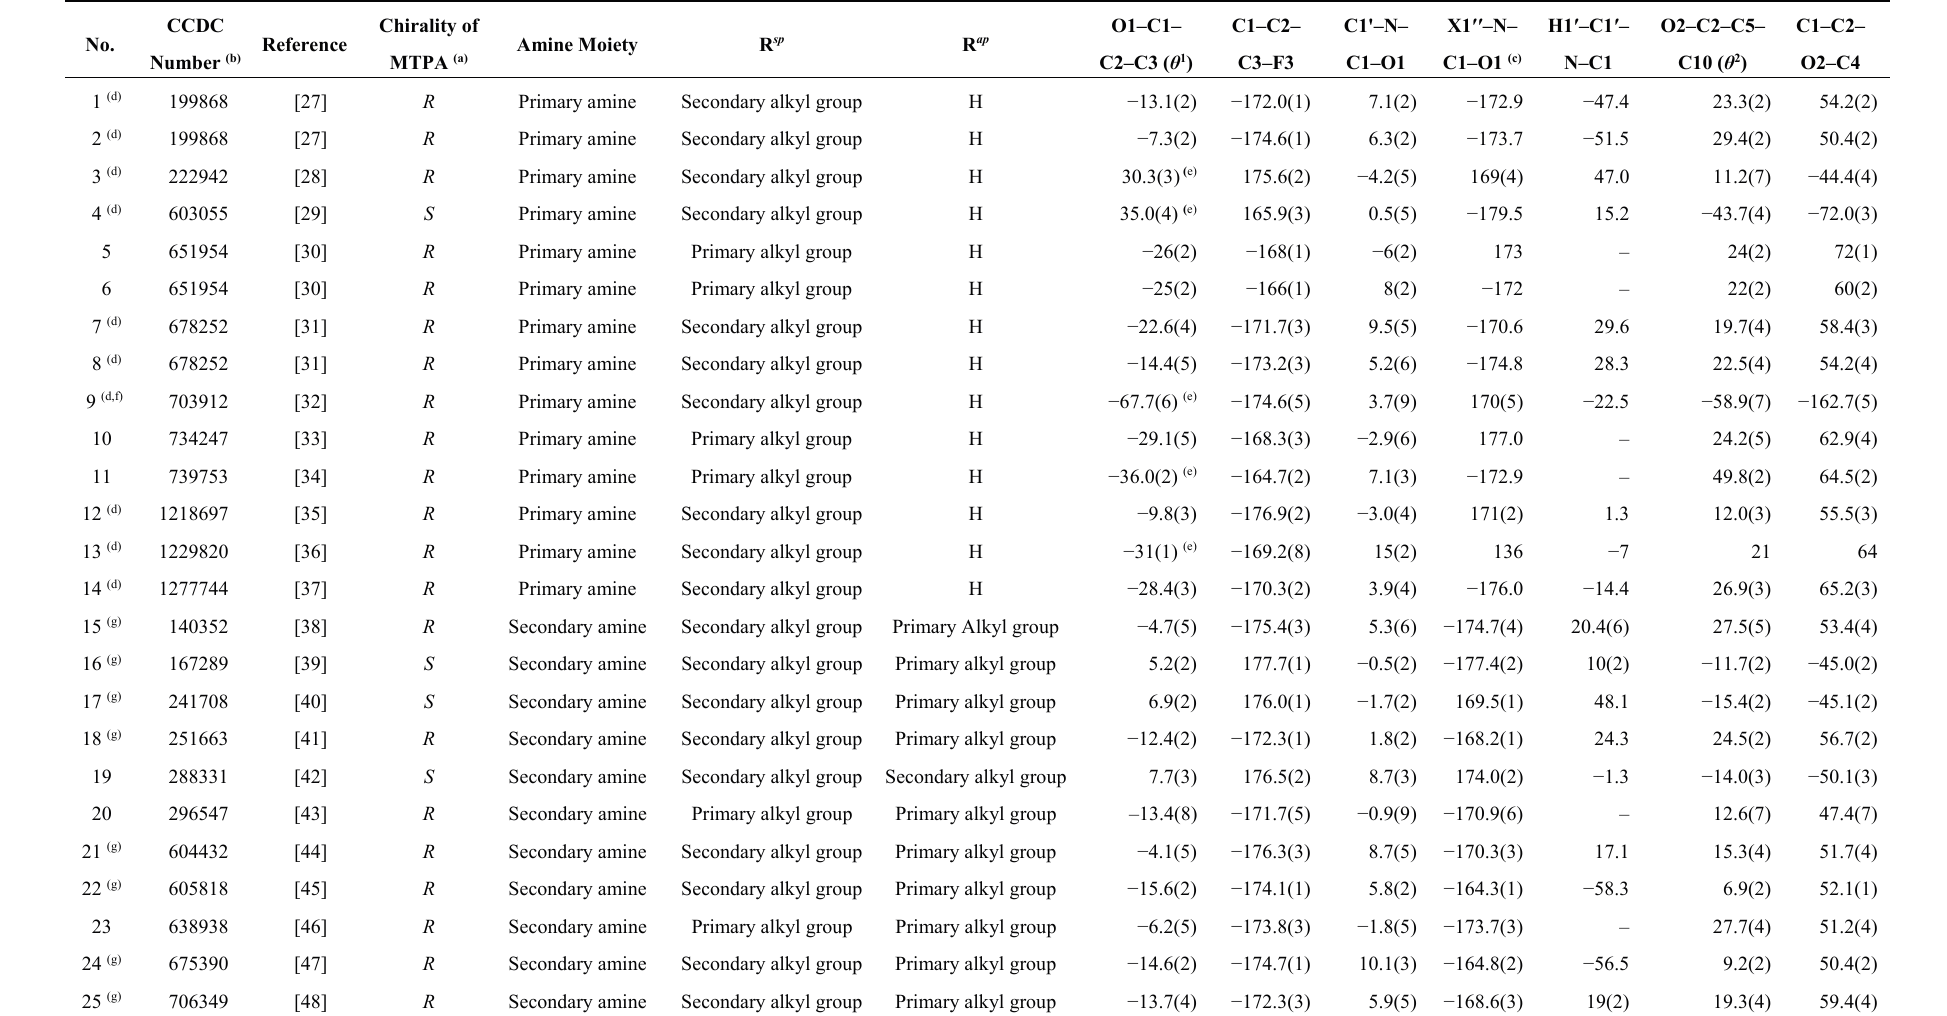
Table 1. Dihedral angles of crystalline MTPA amides (a)